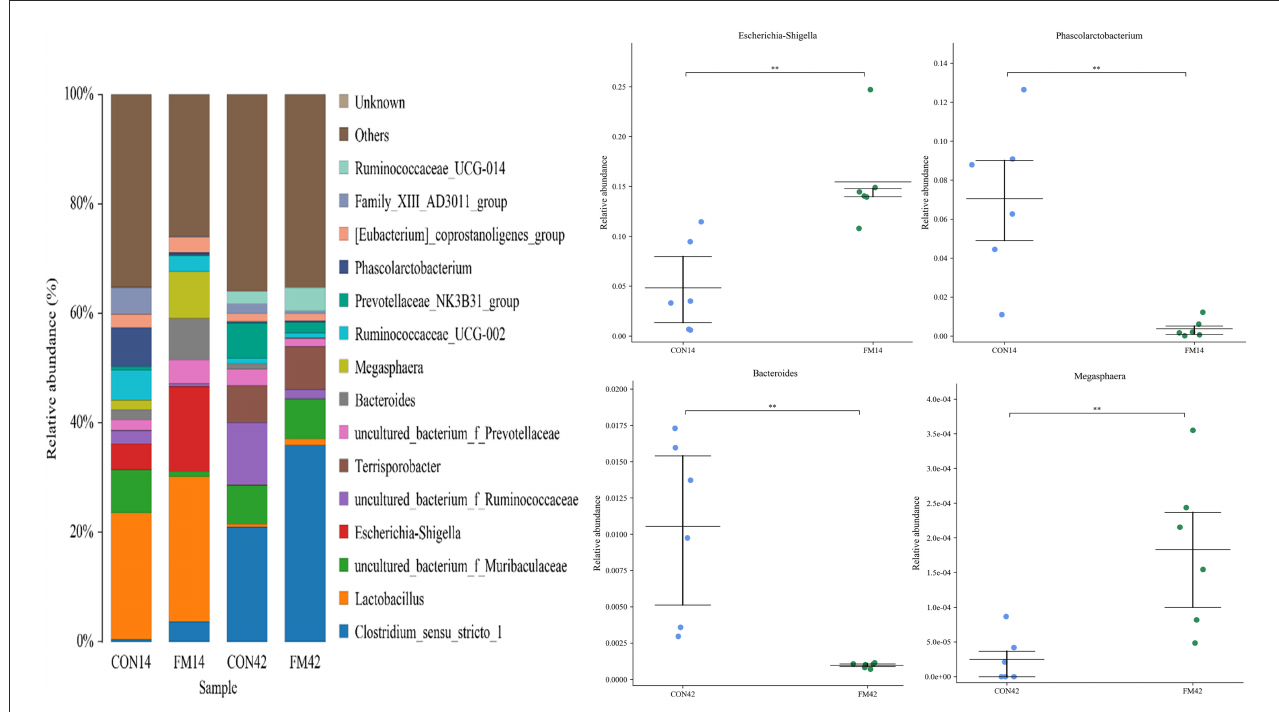
FIGURE7 Fecal microbiota richness and diversity at genus level ( n = 6). The left side of the figure shows the composition of the bacteria, and the right side shows the bacteria with extremely significant differences at genus level.